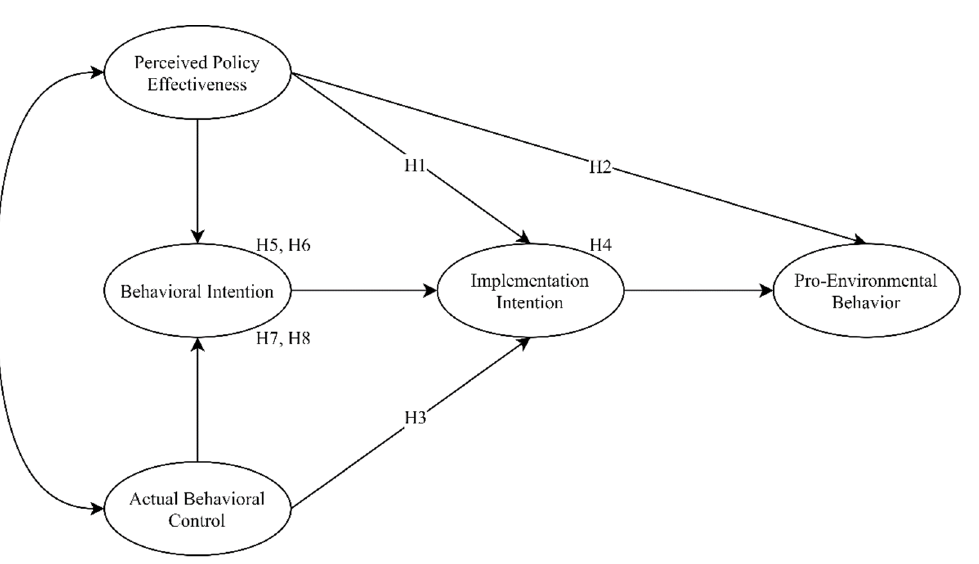
Figure 1. Conceptual model.